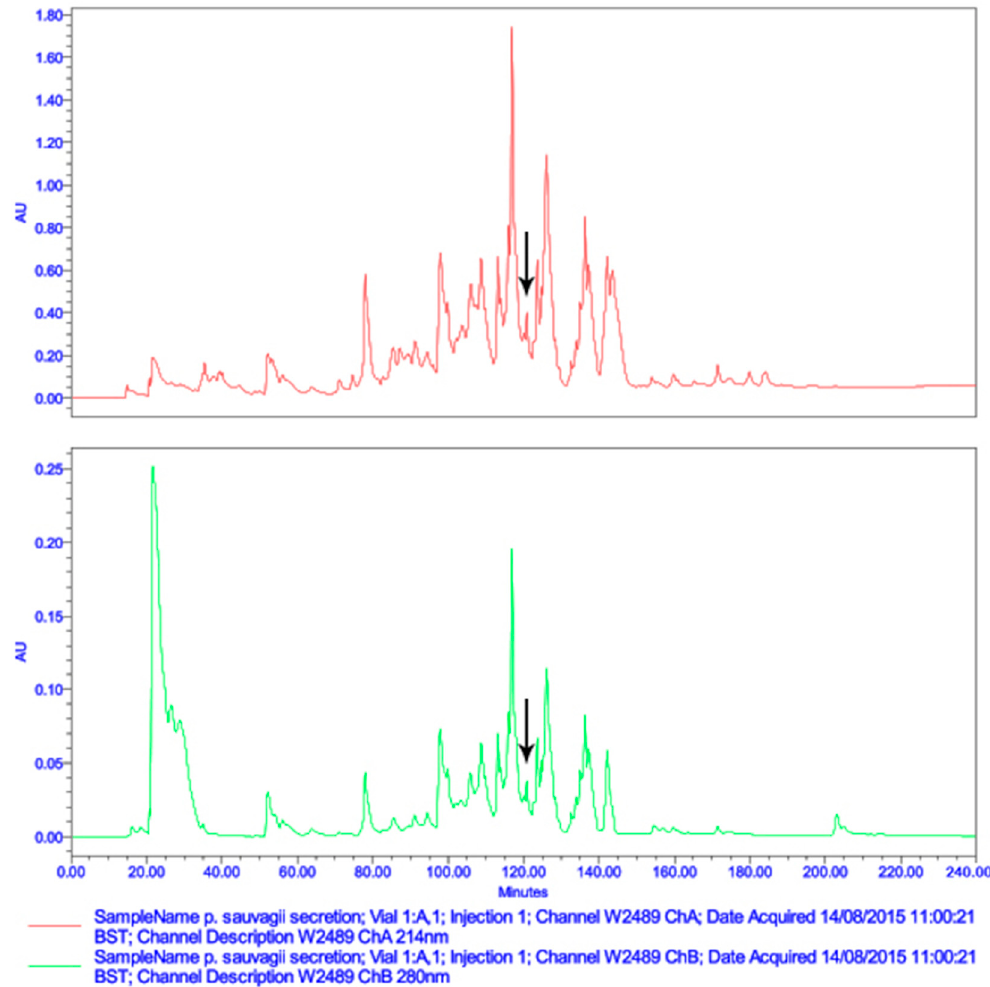
Figure 2. Reverse-phase HPLC chromatogram of lyophilized skin secretion of Phyllomedusa sauvagii . The arrow indicates the retention time / elution position of the fraction containing a mass corresponding to the predicted mature peptide. The absorbance was measured at λ = 214 nm and λ = 280 nm. The X-axis indicates the retention time in minutes and the Y-axis indicates the absorbance in arbitrary units.